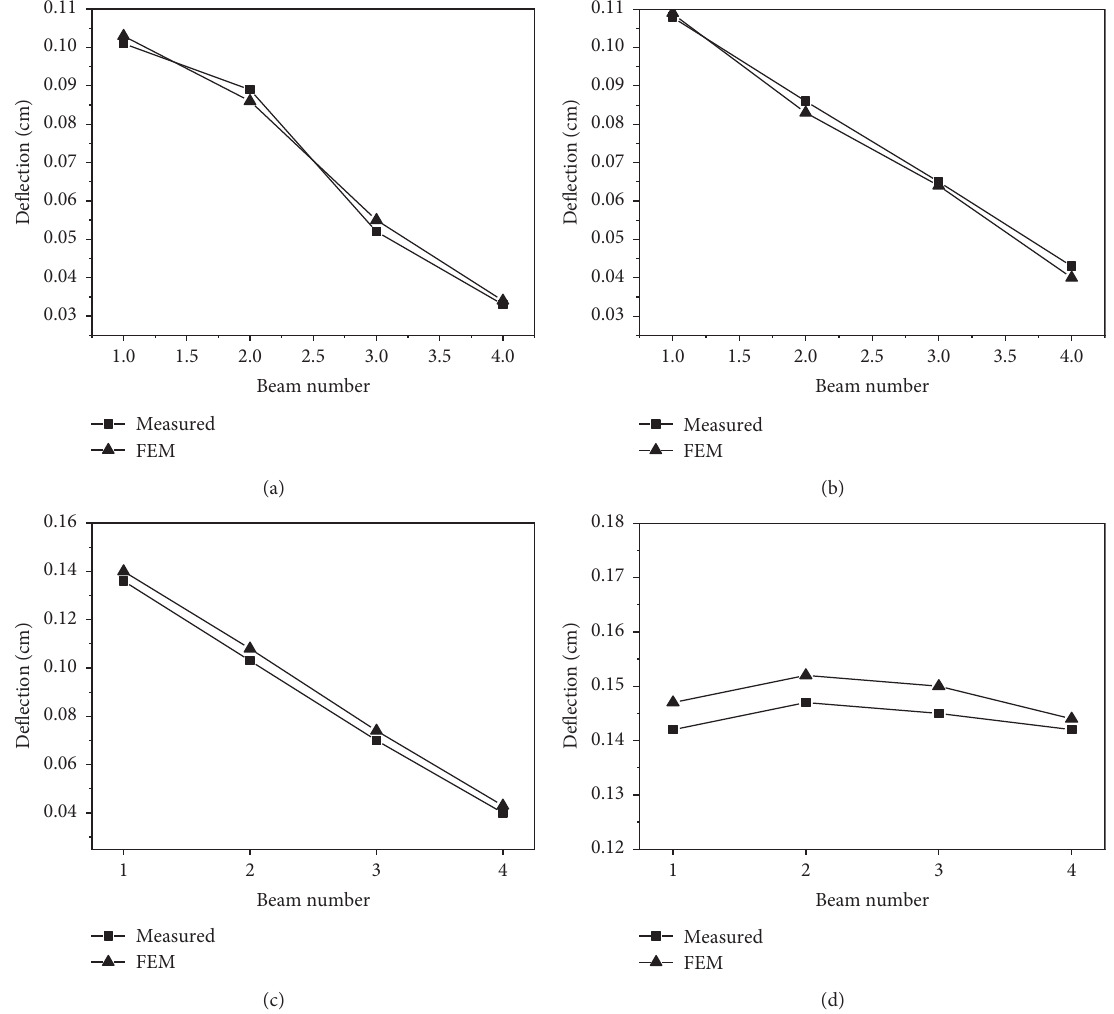
Figure 15: Comparison between numerical and experimental displacement values. (a) Deflections at section A-A during load condition I-1. (b) Deflections at section B-B during load condition I-1. (c) Deflections at section A-A during load condition II-1. (d) Deflections at section B-B during load condition